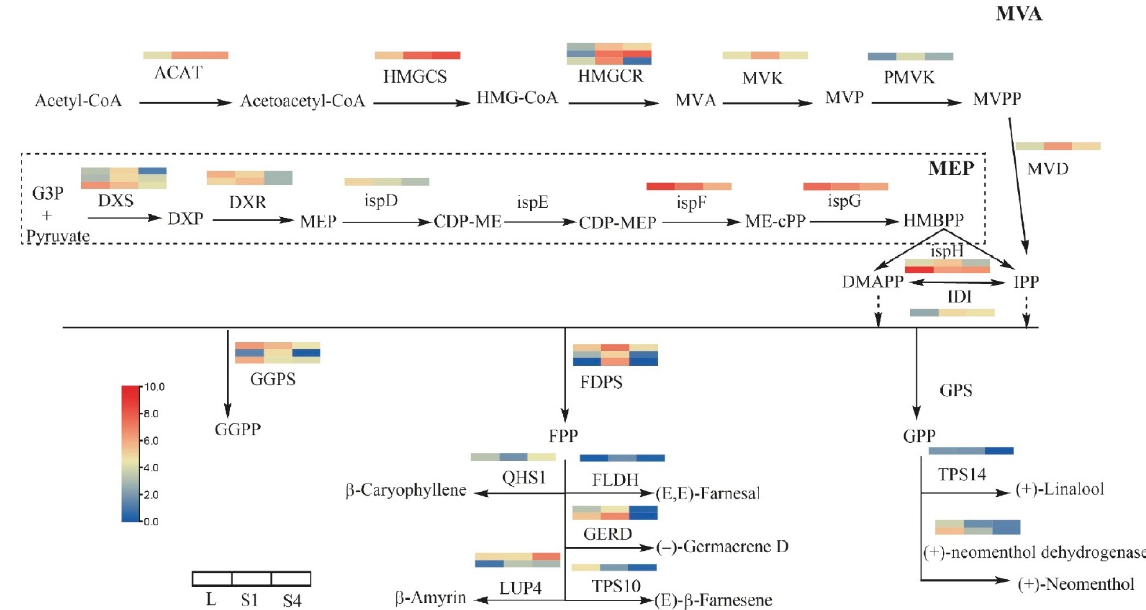
Figure 3. DEGs assigned to terpenoid biosynthesis pathway. The colors show the normalized expression scores from log 2 (FPKM+1) of DEGs. Abbreviations: DXS, 1-deoxy d-xylulose 5-phosphate synthase; DXR, 1-deoxy-D-xylulose-5-phosphate reductoisomerase; ISPD, 2-C-methyl-D-erythritol 4-phosphate cytidylyltransferase; ISPE, 4-diphosphocytidyl-2-C-methyl-D-erythritol kinase; ISPF, 2-C-methyl-D-erythritol 2,4-cyclodiphosphate synthase; ISPG, (E)-4-hydroxy-3-methylbut-2-enyl-diphosphate synthase; ISPH, 4-hydroxy-3-methylbut-2-en-1-yl diphosphate reductase; IDI, isopentenyl-diphosphate delta-isomerase; ACAT, acetyl-CoA C-acetyltransferase; HMGS, hydroxymethylglutaryl-CoA synthase; HMGR, 3-hydroxy-3-methylglutaryl-coenzyme A reductase; MVK, mevalonate kinase; PMVK, phosphomevalonate kinase; MVD, diphosphomevalonate decarboxylase; GPS, geranyl diphosphate synthase; TPS, farnesyl diphosphate synthase; GGPS, geranylgeranyl diphosphate synthase; LUP4, beta-amyrin synthase; GERD, ( − )-germacrene D synthase; SQLE, squalene epoxidase.